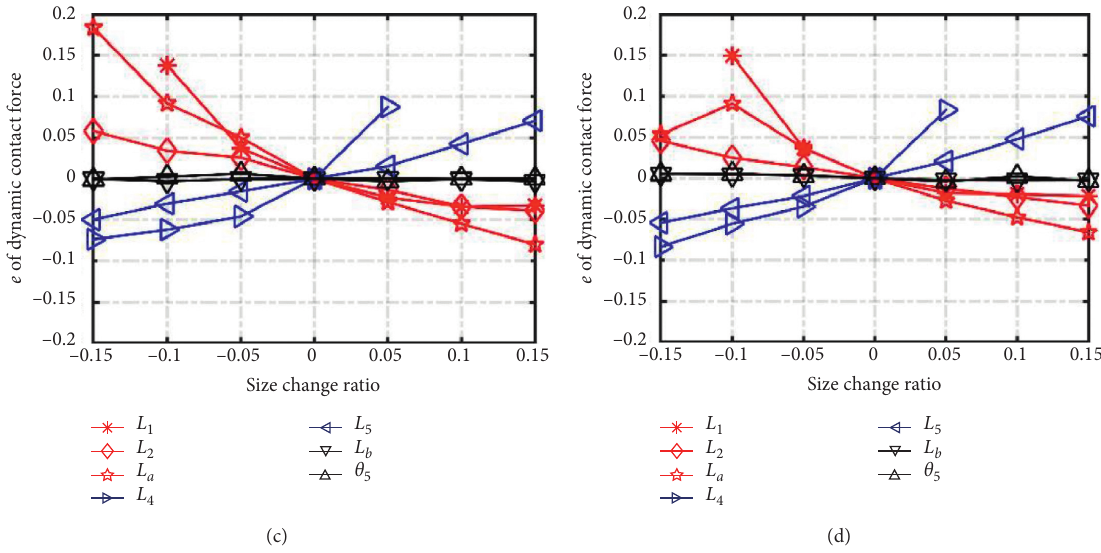
Figure 17: Relative change rate e at different speeds (basically, the red lines mean decrease, the blue lines mean increase, and the black lines mean small change): (a) 200km/h; (b) 250km/h; (c) 300 km/h; (d) 350km/h.